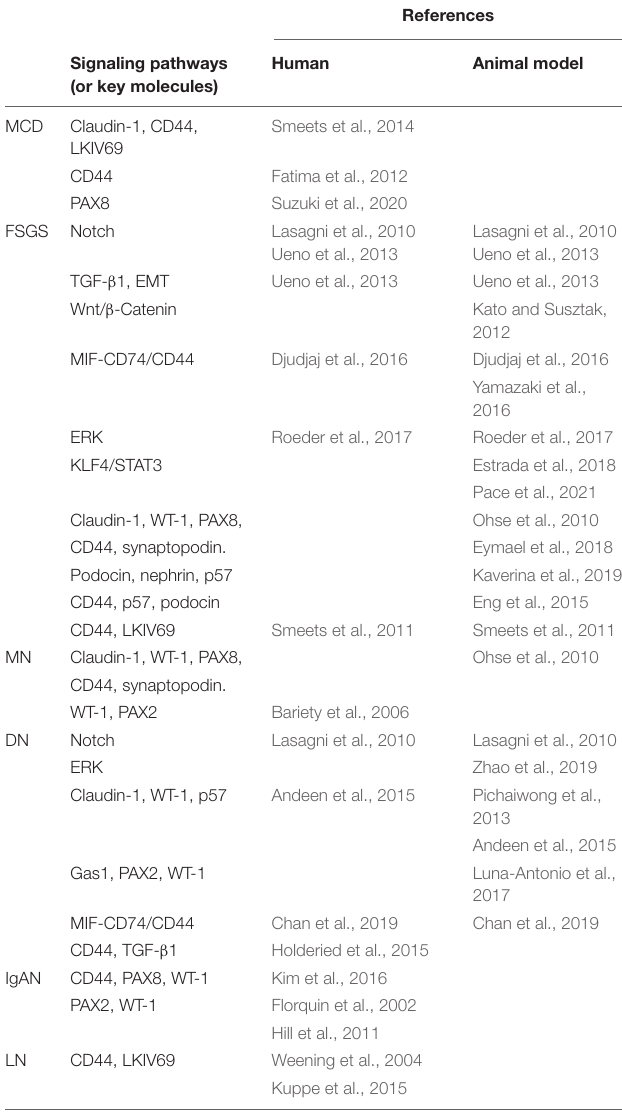
TABLE 1 | Relevant information on PECs activation in